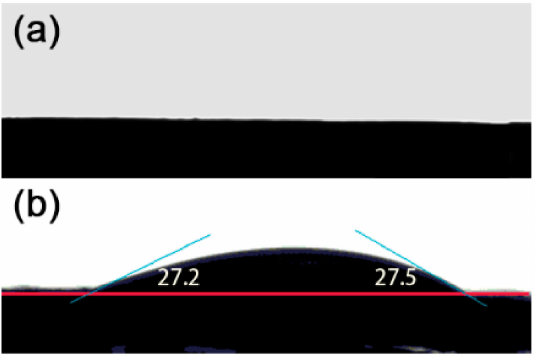
Figure 5. Wettability of the SiO 2 @Ag composite-nanospheres substrates: ( a ) S2, and ( b ) S3.